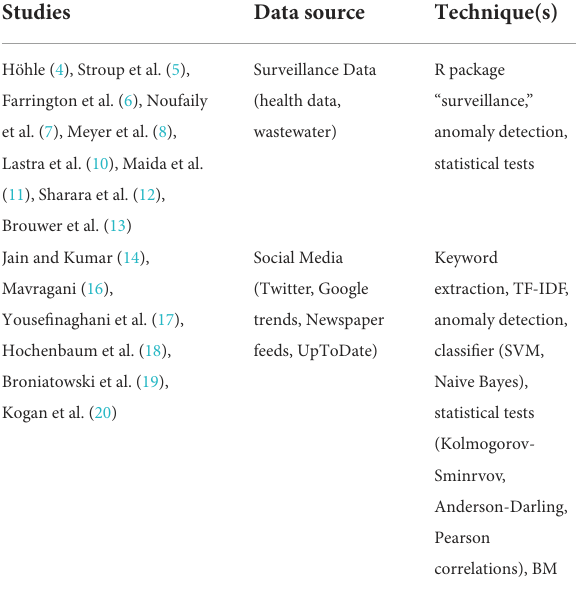
TABLE 1 Included early warning